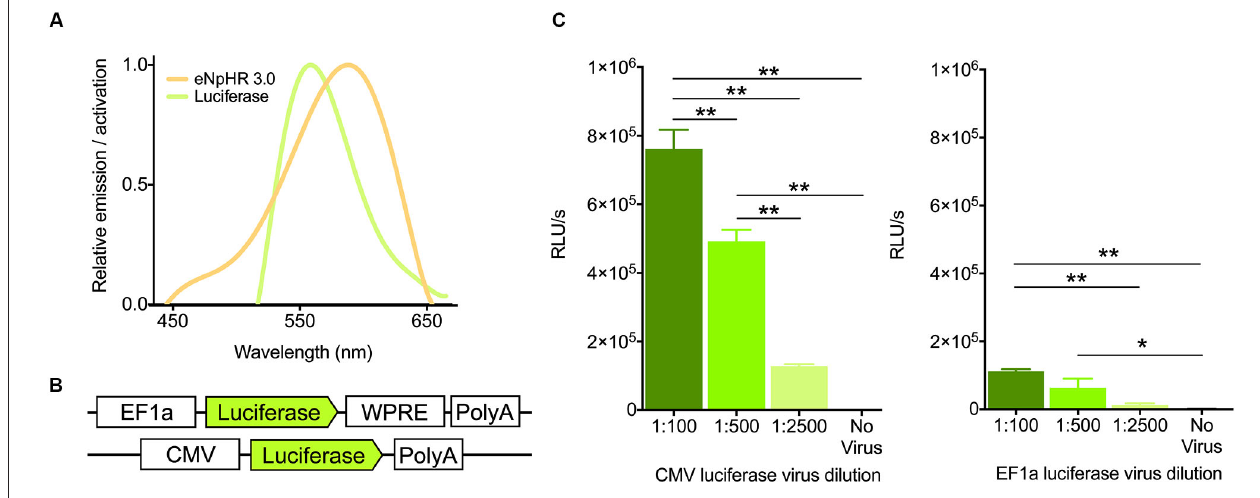
Relative Light Units per second) of the two viral constructs after 24 h of infection at various dilutions of virus in HT-1080 cells ( n = 4 per group for CMV,